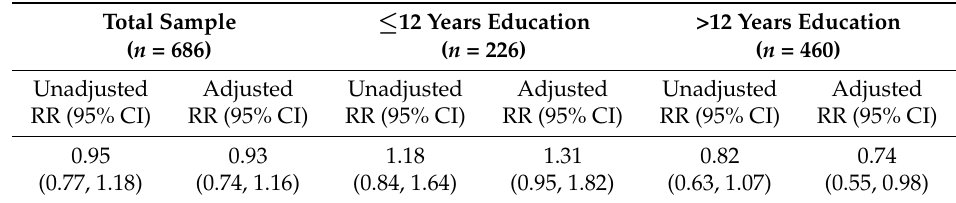
Table 3. Modified Poisson regression results for associations between number of tax foreclosed properties at the block-group level and risk of preterm birth; overall and stratified by educational attainment; Life Influences on Fetal Environments Study ( n = 686),